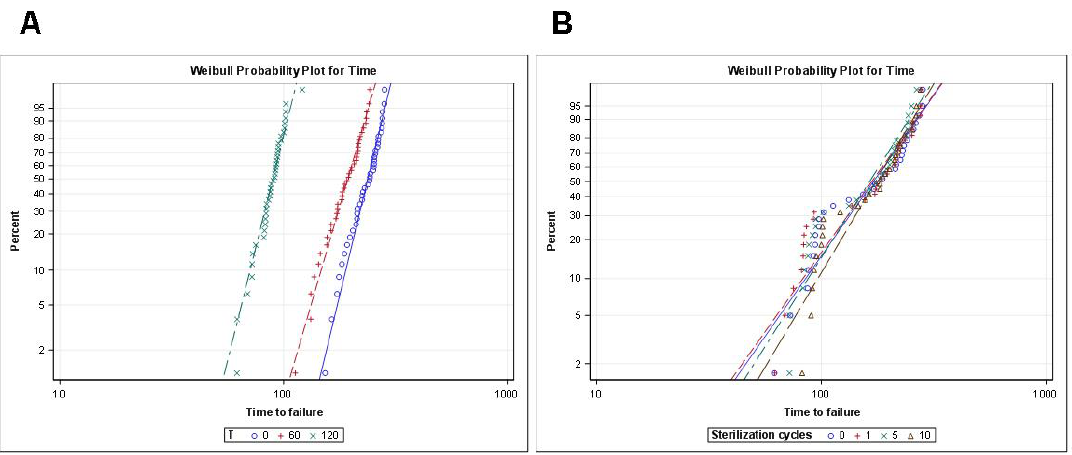
Figure 4. ( A ) Weibull probability plot of time to failure for the time of use and ( B ) sterilization cycles study groups.